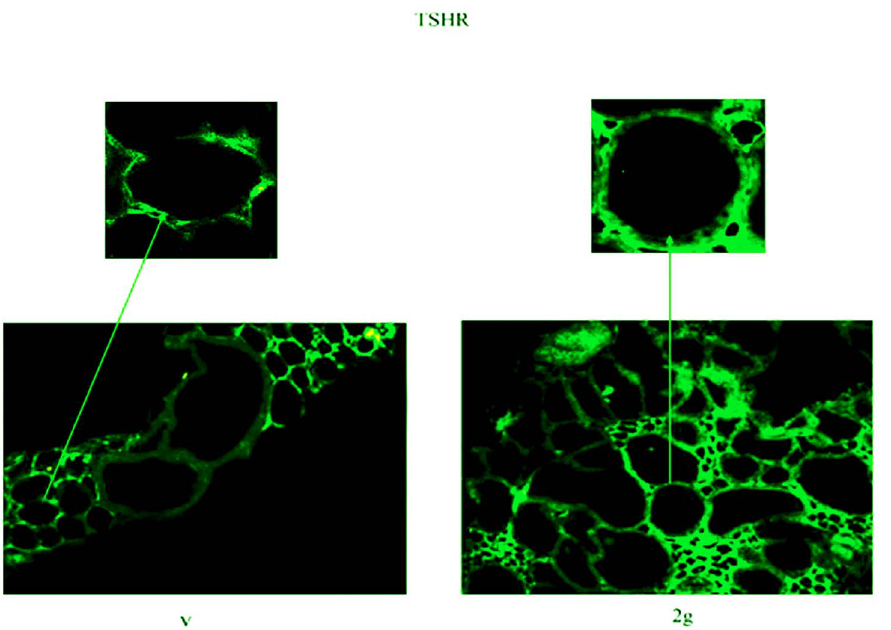
Figure 3. Thyrotropin receptor localization in hypergravity. Fluorescence immunostaining of thyrotropin receptor (TSHR) in thyroid tissues. Analyses were performed using anti-TSHR primary antibody and FITC-conjugated secondary antibody. 20x magnification. The arrows point to the above details of the same areas. The experiment was performed in left lobes of thyroid glands of 3 2gravity (2 g) mice and 3 vivarium (V) mice